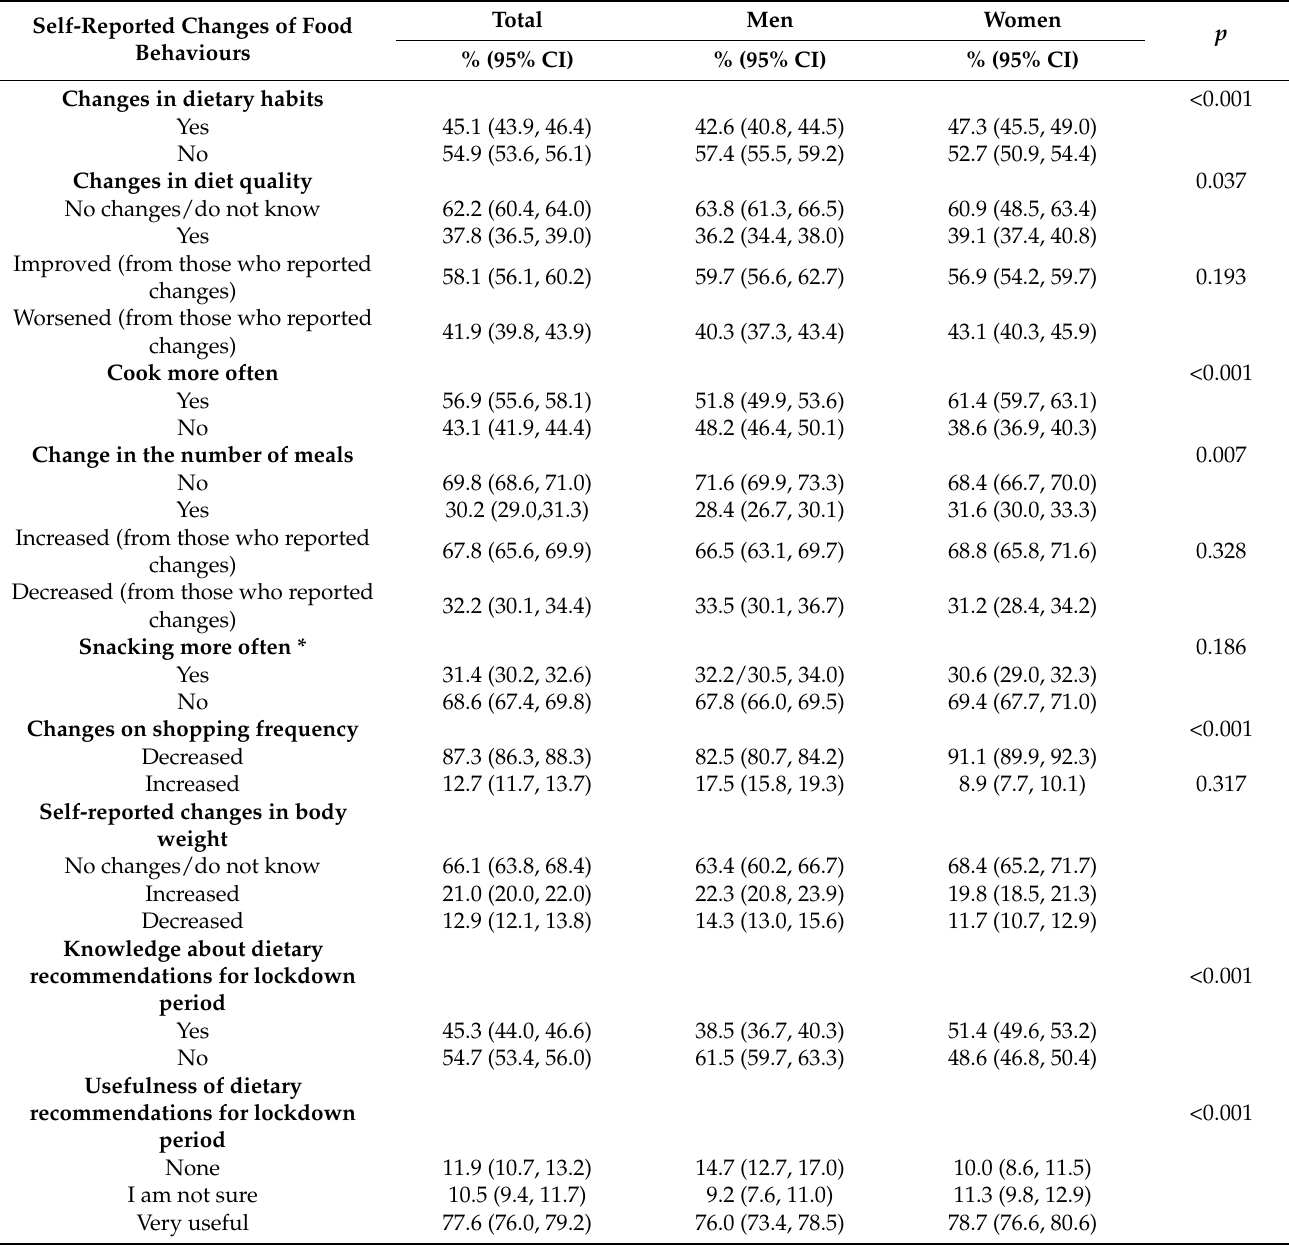
Table 4. Self-reported changes of food behaviours, during COVID-19 social